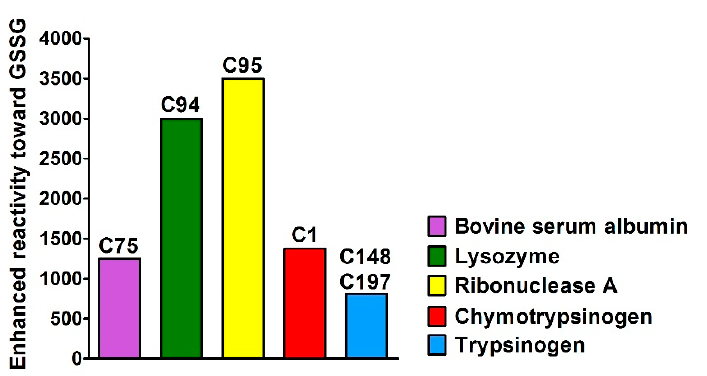
Figure 1. Hyper-reactivity of structural cysteines in five different proteins. Hyper-reactivity of Cys75, Cys94, Cys95, Cys1, Cys148 and Cys197 toward GSSG found in albumin, lysozyme, ribonuclease A, chymotrypsinogen, and trypsinogen, respectively. Pseudo first-order kinetic constants were normalized to that of an unperturbed protein cysteine.